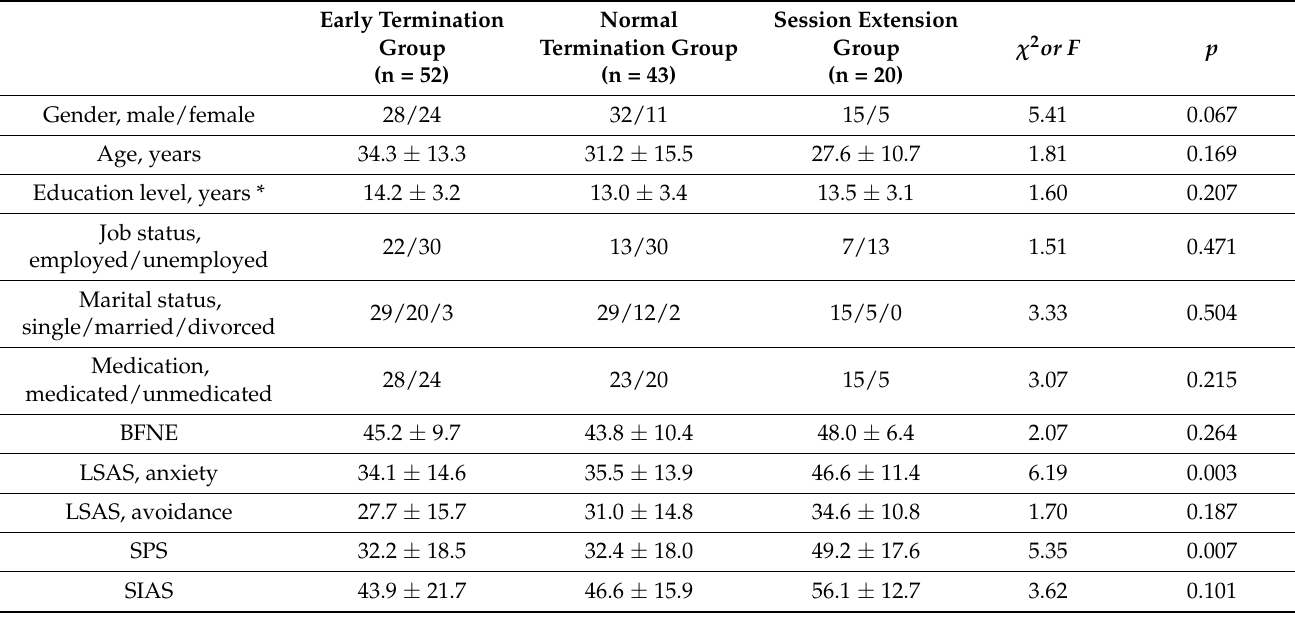
Table 1. Demographic variables and psychological measures of the early termination, normal termination, and session extension groups before virtual reality-based cognitive behavioral therapy.